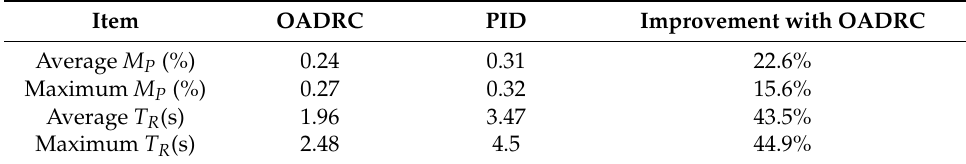
Figure 16. Disturbance rejection performance comparison with step change of variable-geometry turbocharger (VGT) vane.